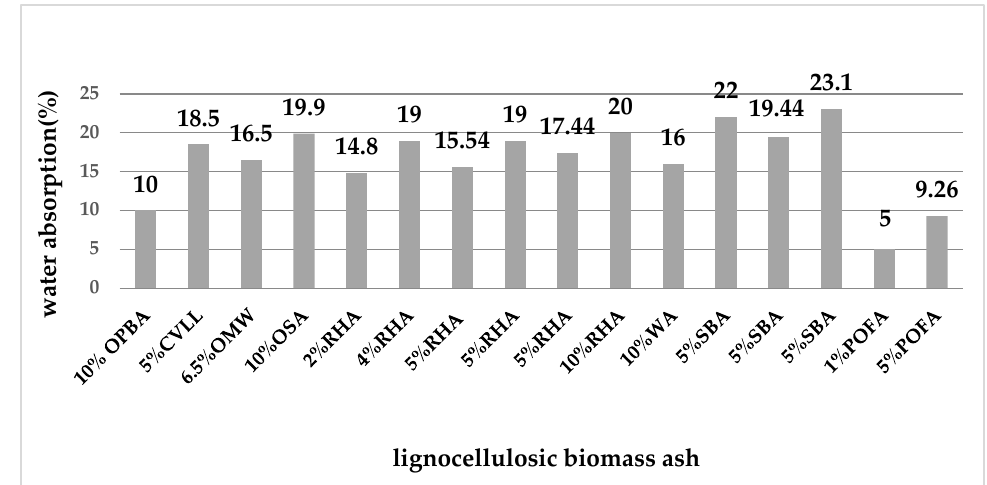
Figure 4. Water absorption for samples made with lignocellulosic biomass ash: 10% OPBA [60], 5% CVLL [61], 6.5% OMW [63], 10% OSA [62], 2% RHA [32], 4% RHA [31], 5% RHA [64], 5% RHA [67], 5% RHA [68], 10% RHA [65], 10% WA [65], 5% SBA [67], 5% SBA [68], 5% SBA [66], 1% OPFA [70], 5% OPFA [69].